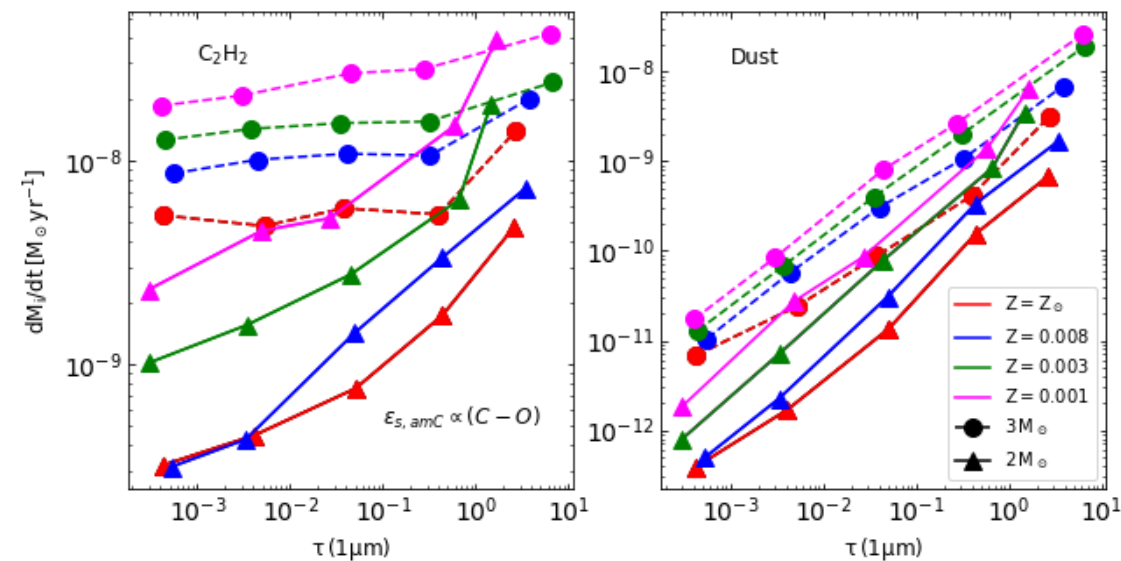
Figure 1. Injection rate of C 2 H 2 molecules (left panel) and of dust (right panel) as a function on τ 1 for different metallicity values and initial stellar masses, as indicated in the figure legend. The seed particle abundance for amC dust is assumed to be proportional to the carbon excess (see Table